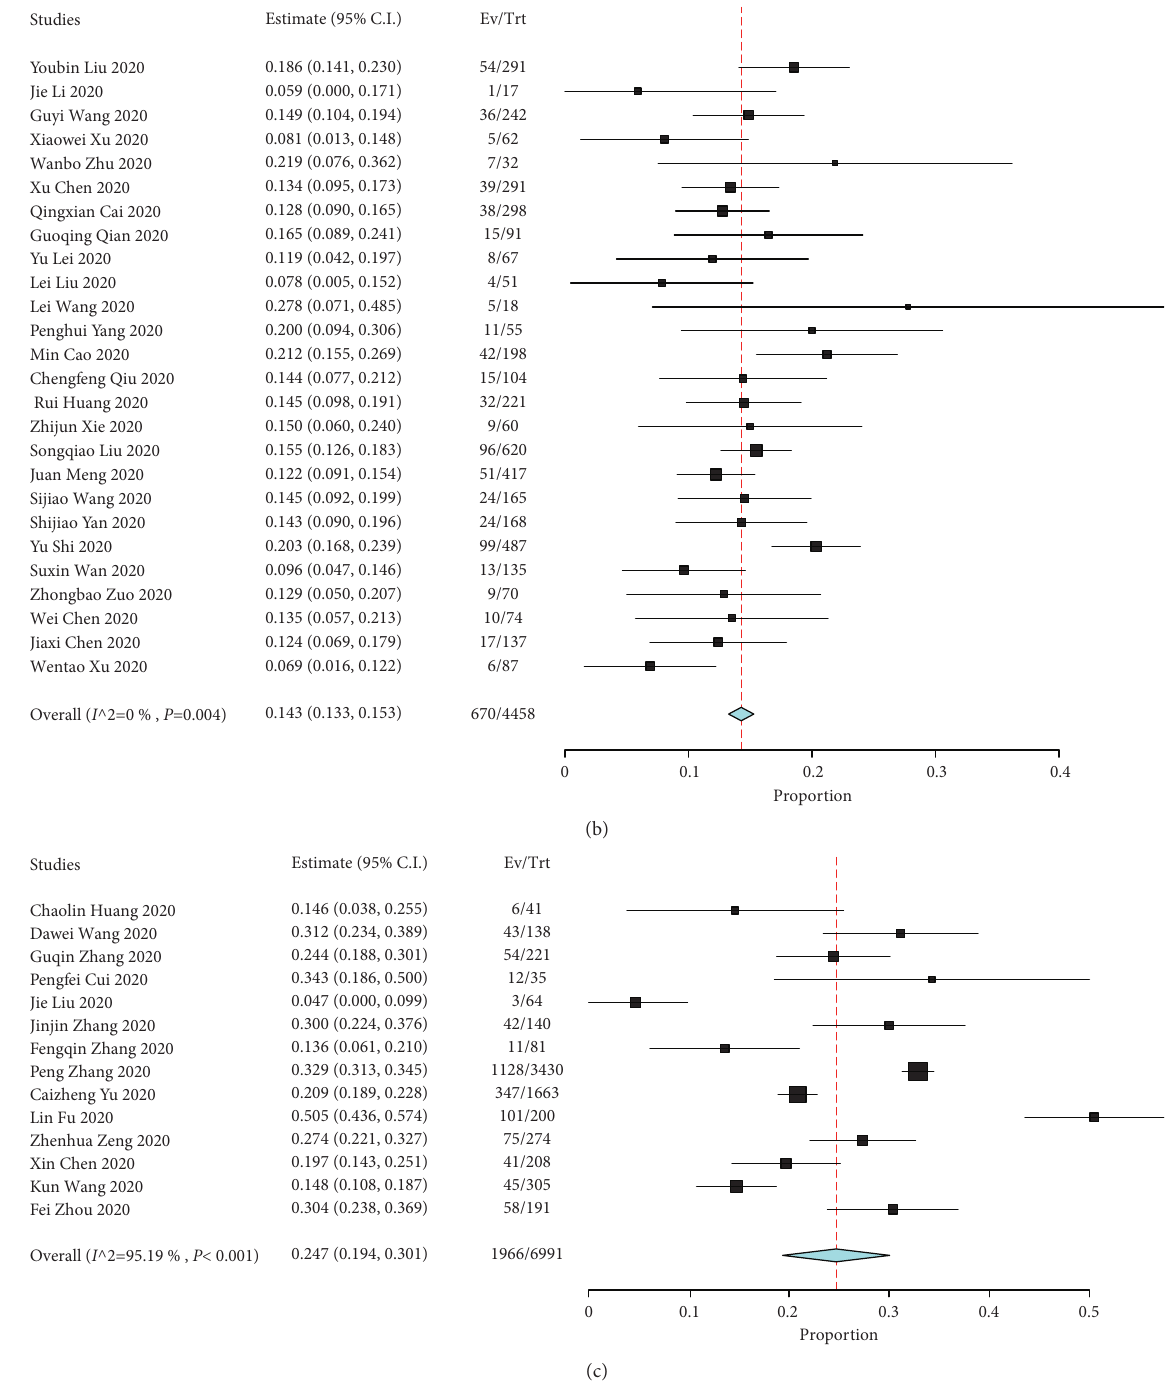
Figure 2: Meta-analysis for the proportion of hypertension in COVID-19 cases. Weights were calculated from binary random-effects model analysis. Values represent the proportion of hypertension in COVID-19 patients and 95% CI. Heterogeneity analysis was carried out using the Q test among the studies variation ( I 2 index). (a) The proportion of hypertension in data from all of China. (b) The proportion of hypertension outside Hubei. (c) The proportion of hypertension in